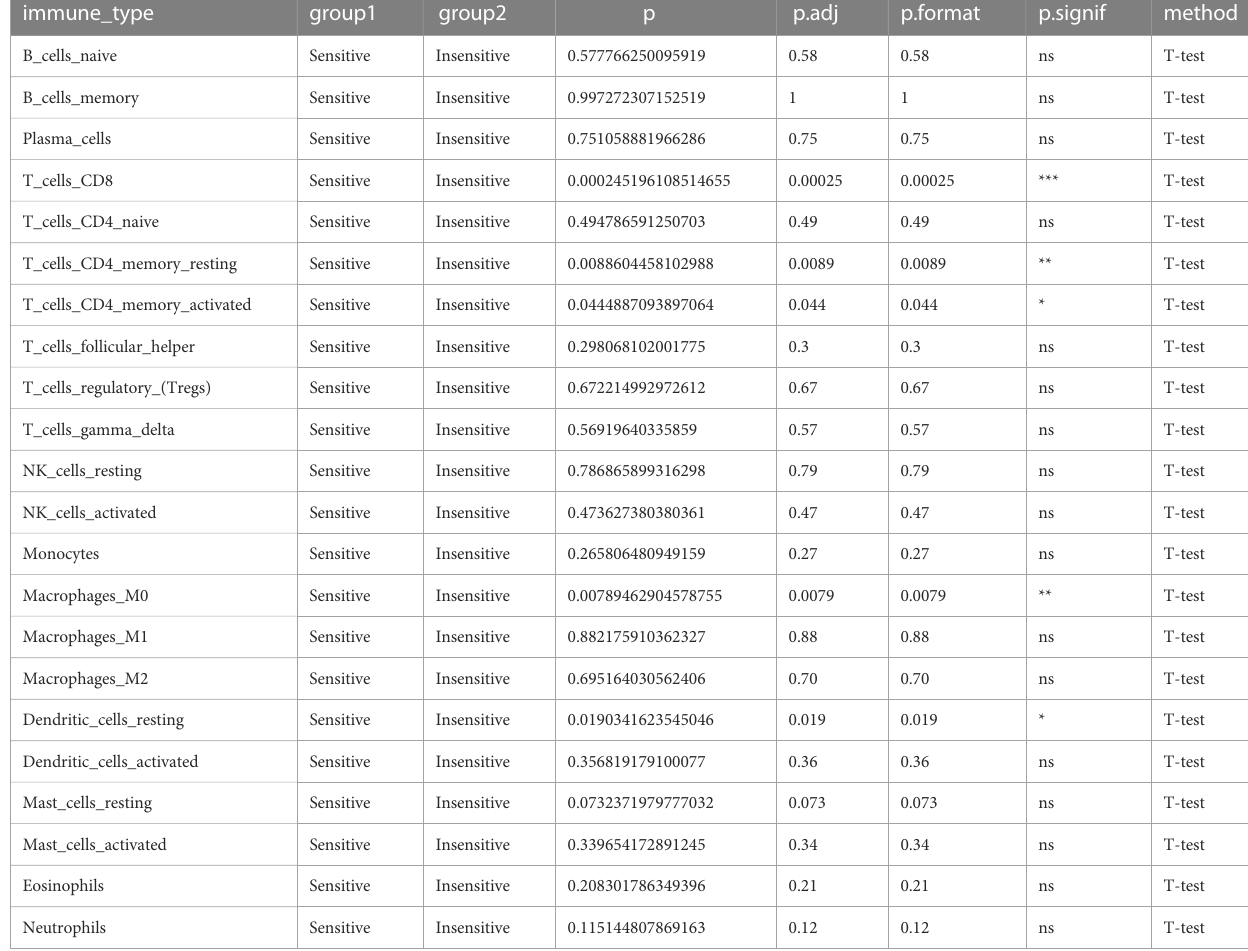
TABLE 1 Immune cell in fi ltration types and chemotherapy response in GSE25066